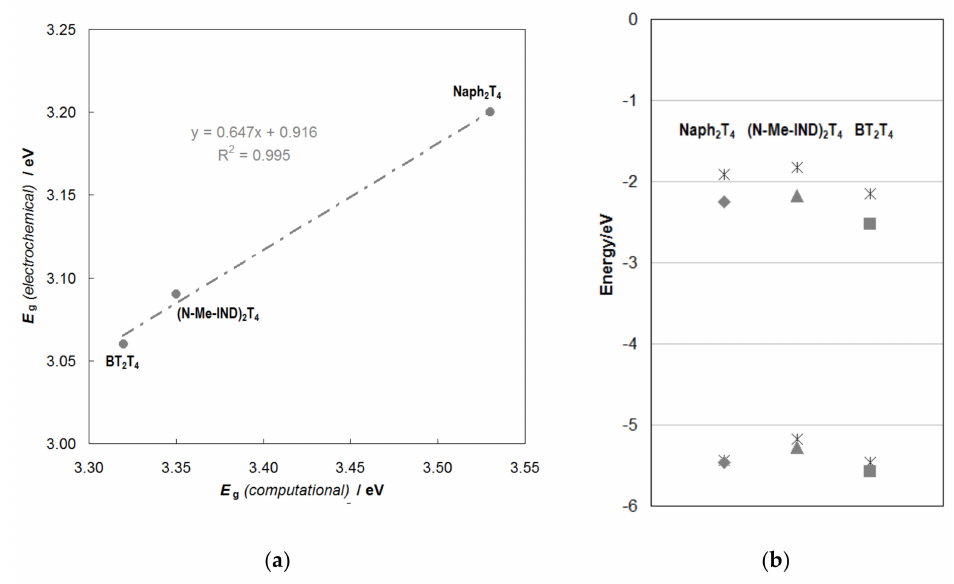
Figure 7. ( a ) Correlation between energy gaps ( E g ) calculated in a vacuum and observed in electrochemical experiments in acetonitrile with 0.1 M TBAPF 6 as a supporting electrolyte, for Naph 2 T 4 (this work), (N-Me-IND) 2 T 4 [8] and BT 2 T 4 [21]. ( b ) Calculated (full symbols) and electrochemical (asterisk) HOMO and LUMO levels in the three